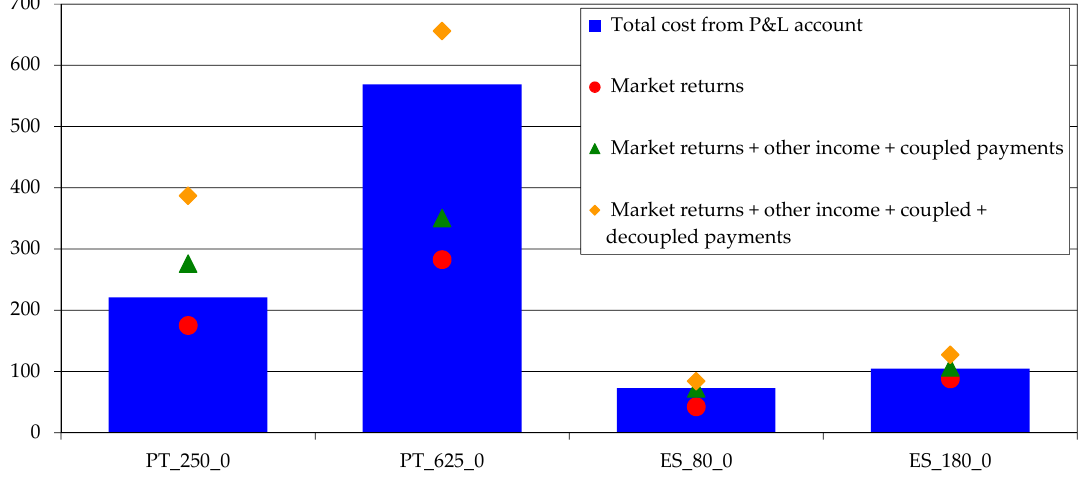
Figure 6. Whole farm profitability (1000 €/farm). Source: model results.